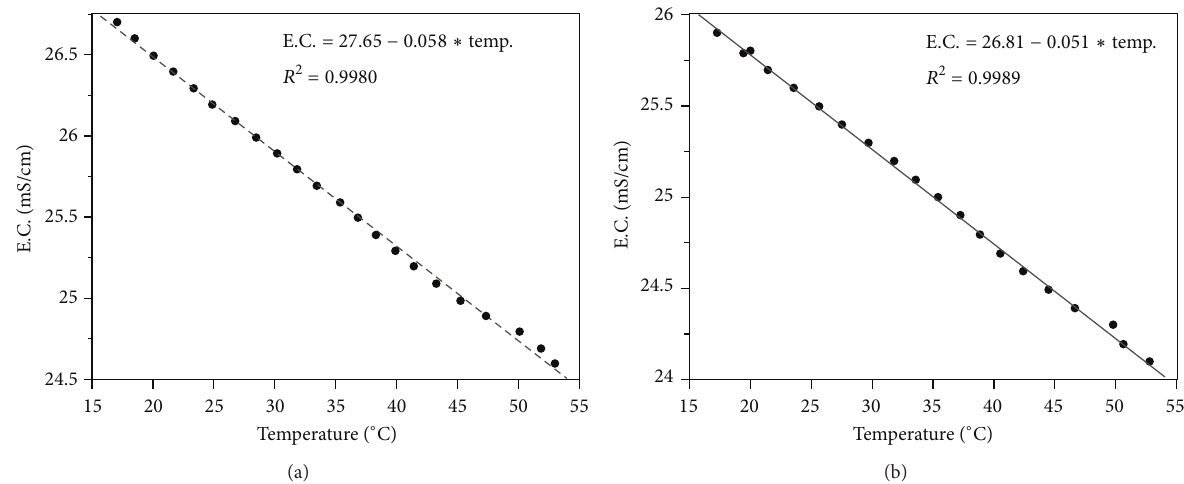
Figure 1: Electrical conductivity (E.C.) of urea-NB-NH 4 Cl solution with 0.1M urea (a) and 1M urea (b) versus temperature.